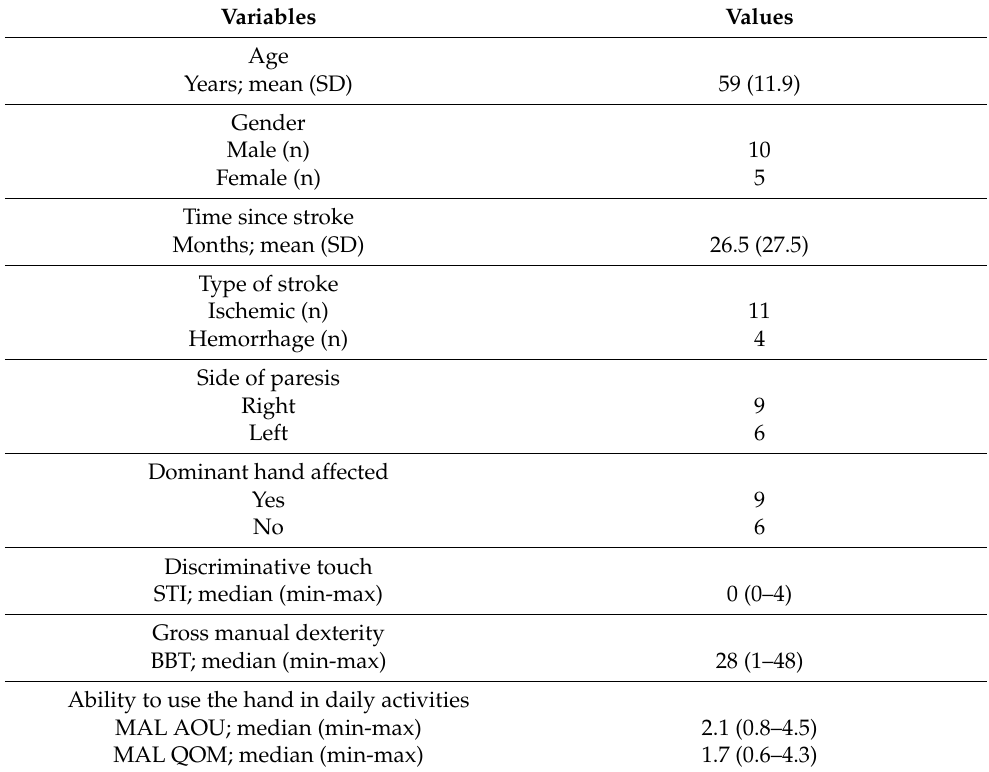
Table 1. Characteristics of the 15